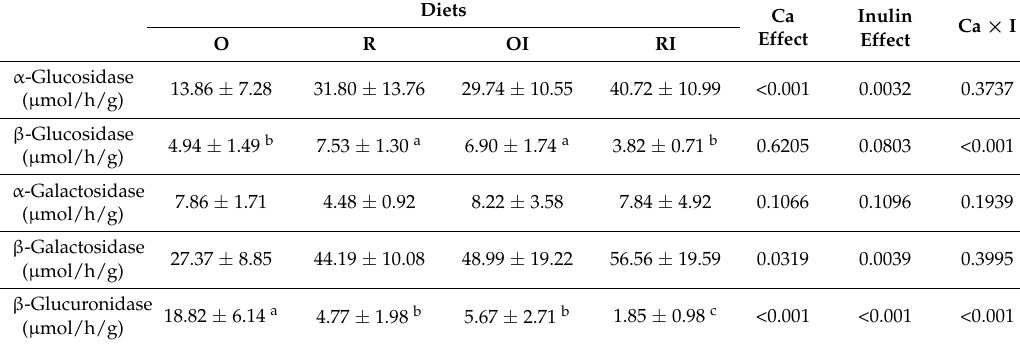
Table 4. The activity of bacterial enzymes in the caecal digesta of rats fed the experimental GFDs *.